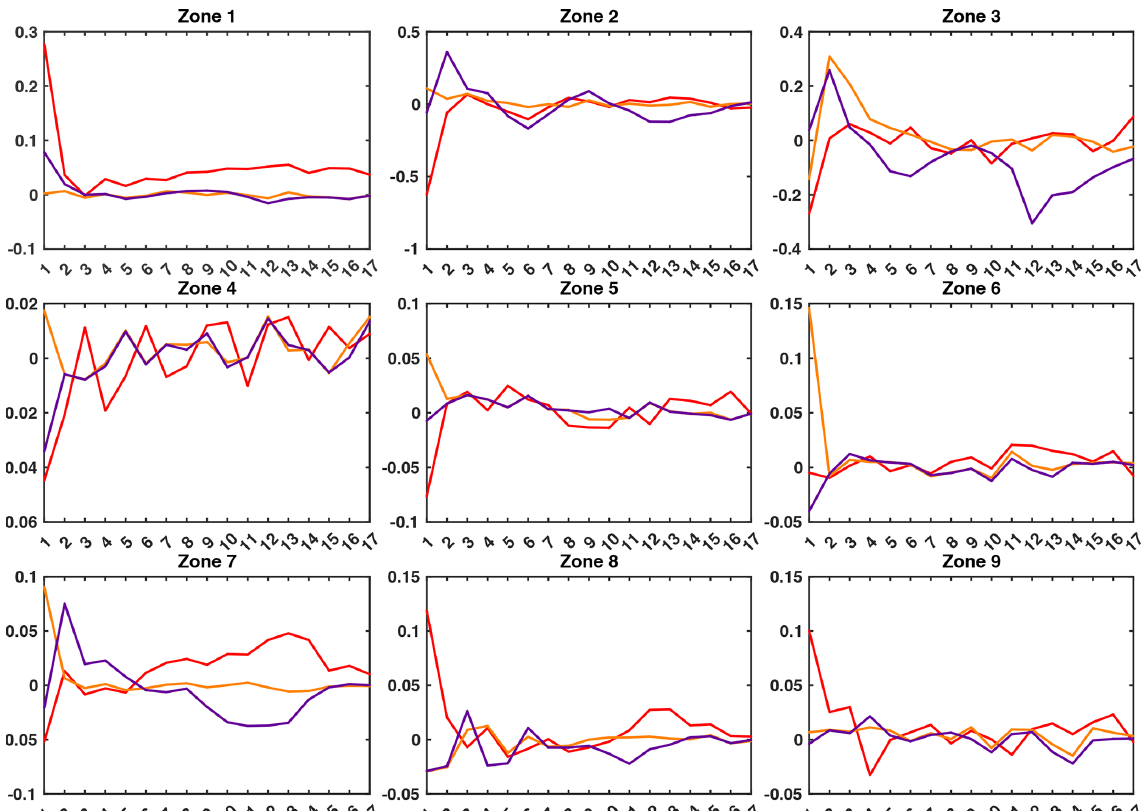
(cid:16) (cid:17) [ l ] − H k ( x b, [ l ] ) y o , ” term in Eq. 13) with respect to the assimilation cycle for PE1 k k